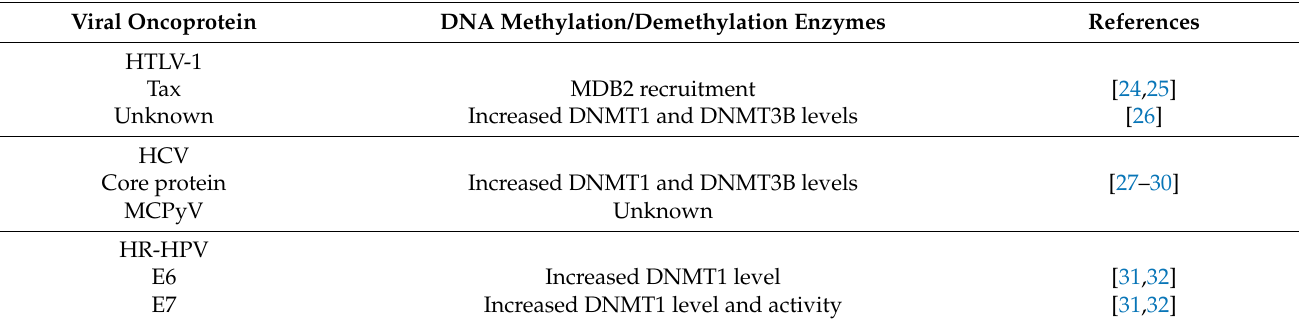
Table 1. Effects of viral oncoproteins on DNA methylating/demethylating enzymes. See text for details. Viral Oncoprotein DNA Methylation/Demethylation